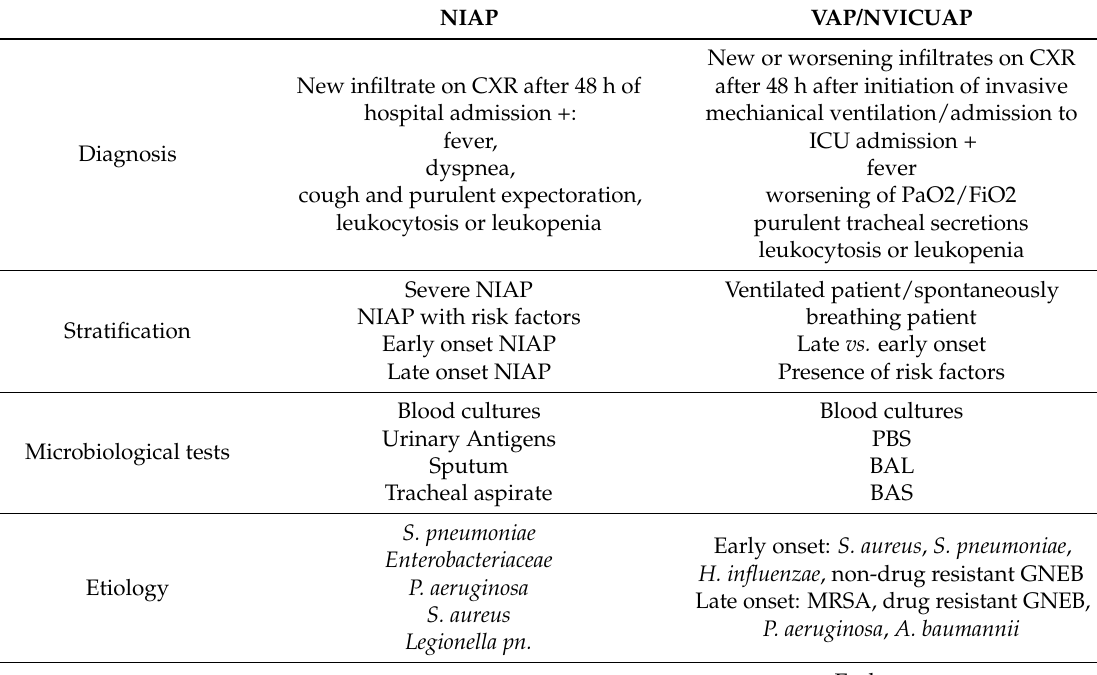
Table 4. Overview of NIAP vs. VAP/NV-ICUAP.